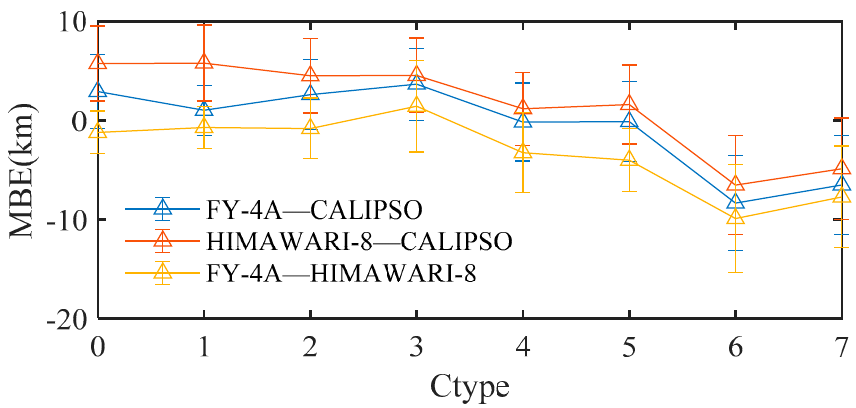
Figure 5. MBE between different satellites varies with cloud types. The error bars represent